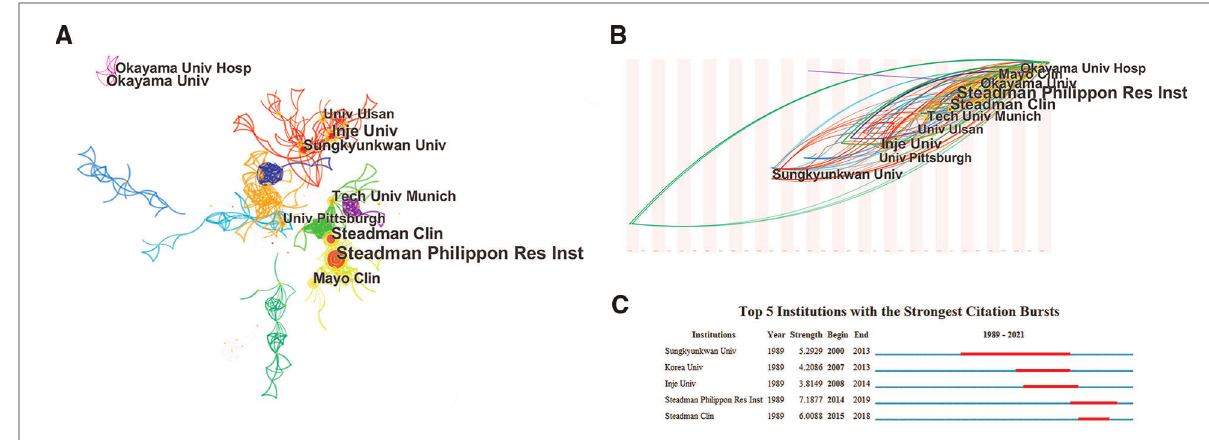
FIGURE 3 The collaboration network among institutions for eniscal root tears research. ( A ) The clusters of cooperation network of the publishing institutions. ( B ) Time zone diagram of the clusters of cooperation network of the publishing institutions. ( C ) The strongest citation bursts of institutions.